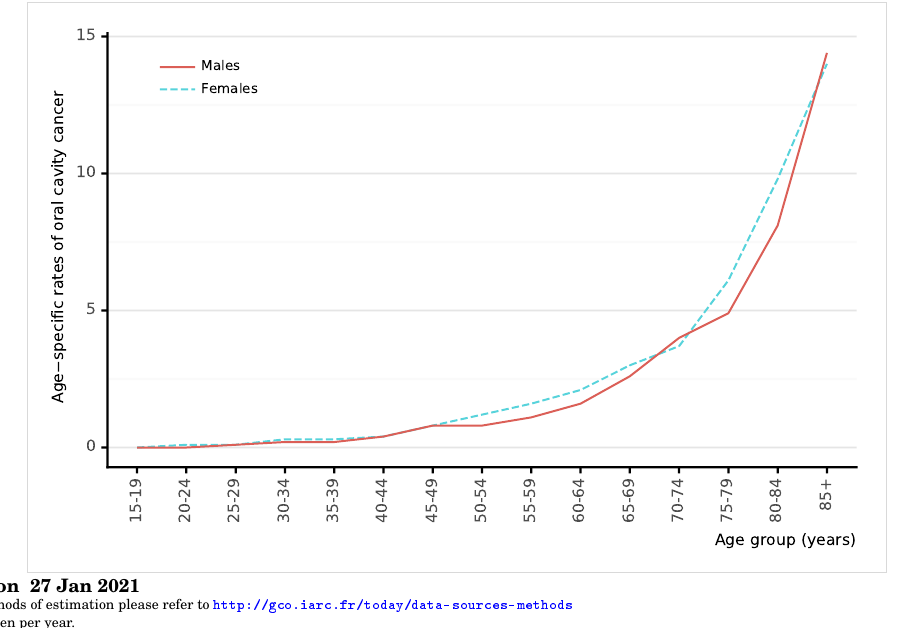
Figure 44: Age-specific mortality rates of oral cavity cancer in Peru (estimates for 2020)